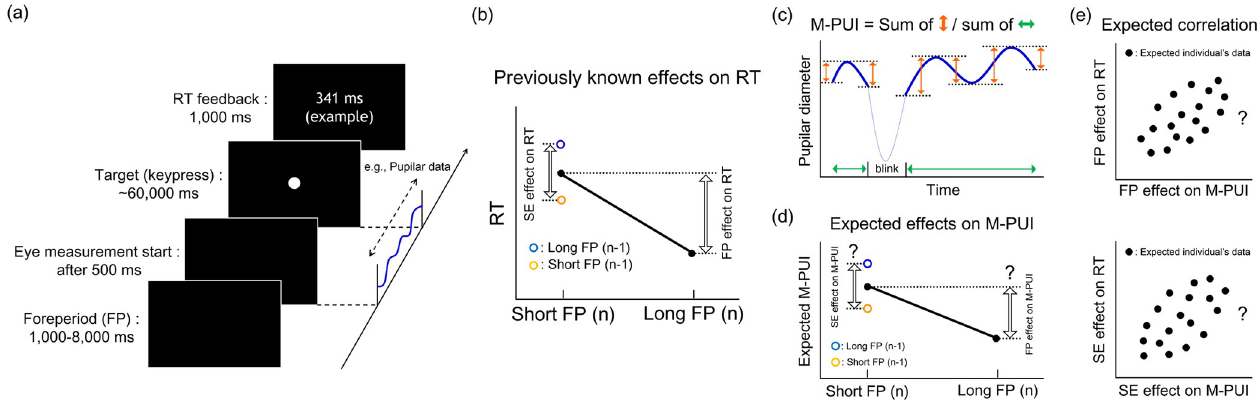
Fig 1. Summary of current study’s procedure and hypothesis. (a) Serial flow of elements in one trial of the Psychomotor Vigilance Task. A white dot target appeared after a random interval ranging from 1,000 to 8,000 ms in 250 ms increments. We asked the participants to make a keypress for the target appearance as quickly as possible. After the response, the feedback of the RT was displayed. We used the pupilar diameter from 500 ms after the start of the trial to the target appearance to exclude the possible noise (cf. [24]). (b) Previously known temporal attention effects on RT, i.e., FP/SE effects on RT. RT should be shorter when FP (n) is longer than when FP (n) is shorter. The difference in RT between short and long FP (n) is defined as the FP effect on RT (cf. [24]). As for the SE effect, RT should be longer when FP (n-1) is longer than when FP (n-1) is shorter only for the short FP (n). The difference in RT between long FP (n- 1) and short FP (n-1) is defined as the SE effect on RT (cf. [24]). (c) The conceptual example of M-PUI calculation. The solid blue line represents the valid smoothed pupilar diameter. The dotted blue line represents the invalid smoothed pupilar diameter during a blink. We first calculated the absolute value of change in pupillary fluctuation degree (sum of the magnitude of orange arrows). Then, the absolute degree of change was divided by the length of a valid pupilar diameter (sum of the magnitude of green arrows). (d) The expected temporal attention effects on M-PUI; i.e., the FP/SE effects on M-PUI. Similar to RT, the FP/SE effects on M-PUI can be expected, but it has not been investigated to date. (e) The expected inter-individual positive correlation between temporal attention effects, i.e., the FP/SE effects on RT and M-PUI. If the FP/SE effects on M-PUI are positively correlated inter-individually with those of RT, it will provide further evidence that M-PUI reflects temporal attention in the variable FP task.